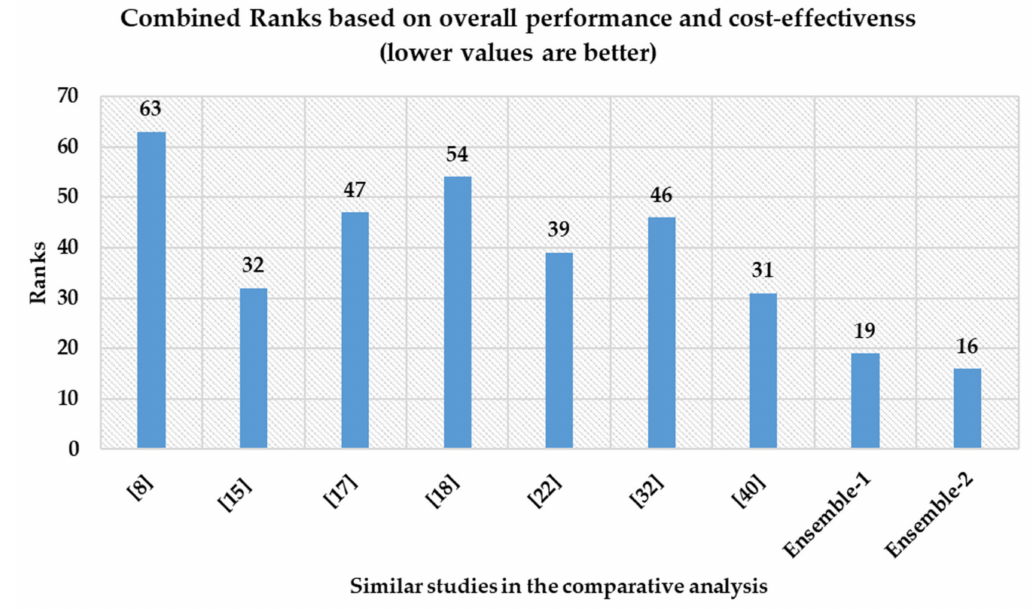
Figure 11. Combined ranks of di ff erent approaches across performance and cost